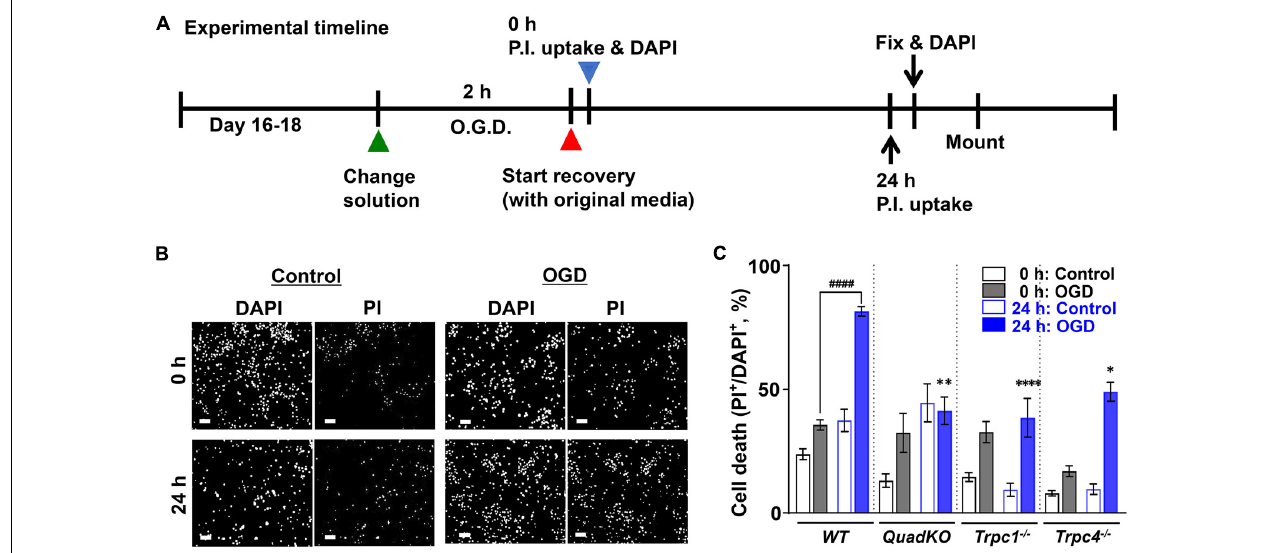
FIGURE 3 | Oxygen and glucose deprivation (OGD)-induced cell death of cultured cortical neurons from wild type, Trpc1 − / − , Trpc4 − / − , and Trpc1/c4/c5/c6 − / − mice. (A) Schematic of the experimental timeline. Primary cultures of cortical neurons (16–18 DIV) from WT, Trpc1 − / − , Trpc4 − / − , and Trpc1/c4/c5/c6 − / − (QuadKO) mice were treated without or with OGD for 2 h and then allowed to grow in normal medium for 0 or 24 h. (B) Representative images of DAPI staining (Bocksch et al., 2010) and PI uptake of cultured cortical neurons from wild type (WT) mice grown under control conditions or subjected to OGD for 2 h. Cells were stained either immediately after the treatment (0 h) or returned to normal culture conditions for 24 h before staining (24 h). Scale bars, 50 µ m. (C) Summary data of PI-positive cells, normalized to the total cell number determined by DAPI staining. Data represent means ± SEM of n = 20 to 30 fields of views for each condition pooled from 4 coverslips of neurons from two separately prepared primary cultures. #### P < 0.0001, ∗ P < 0.05, ∗∗ P < 0.01, ∗∗∗∗ P < 0.0001 vs. WT 24 h: OGD by one-way